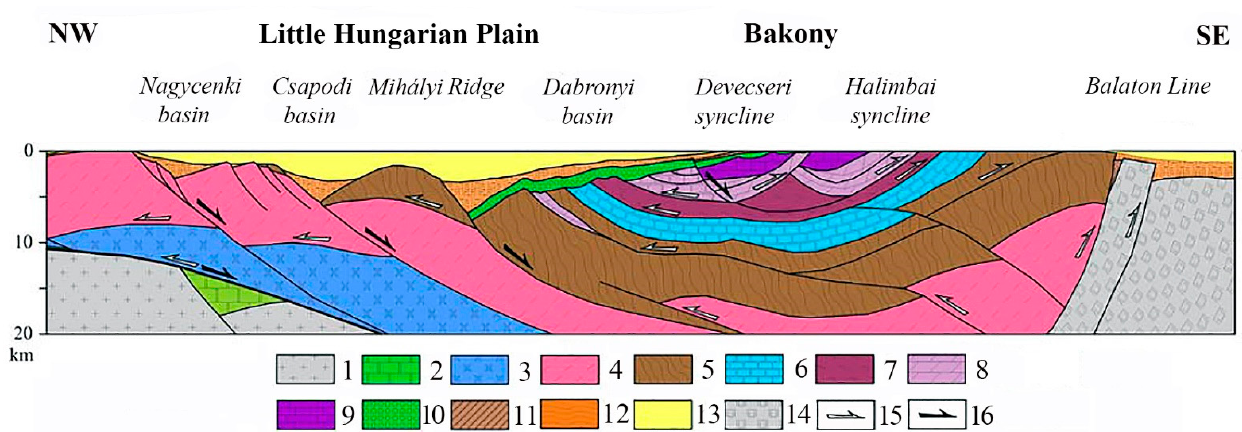
Figure 2. Geological profile [11]. 1. European Upper Crust, 2. European autochton Mesozoic, 3. Penninic, 4. Lower, Upper and Austroalpine Paleozic 5. Uppermost Austroalpine Palozoic, 6. Lower, Middle Triassic, 7. Veszprém Marl 8. Main Dolomite, 9. Dachstein and Kardosréti limestone, 10. Gosau beds, 11. Paleogenic beds, 12. Lower, Middle Miocene beds, 13. Upper Miocene beds, 14. Paleo Mezozoic of dinaric type (Middle Hungarian Main Unit), 15. Mesozoic overthrusts, 16. Miocene dip faults.